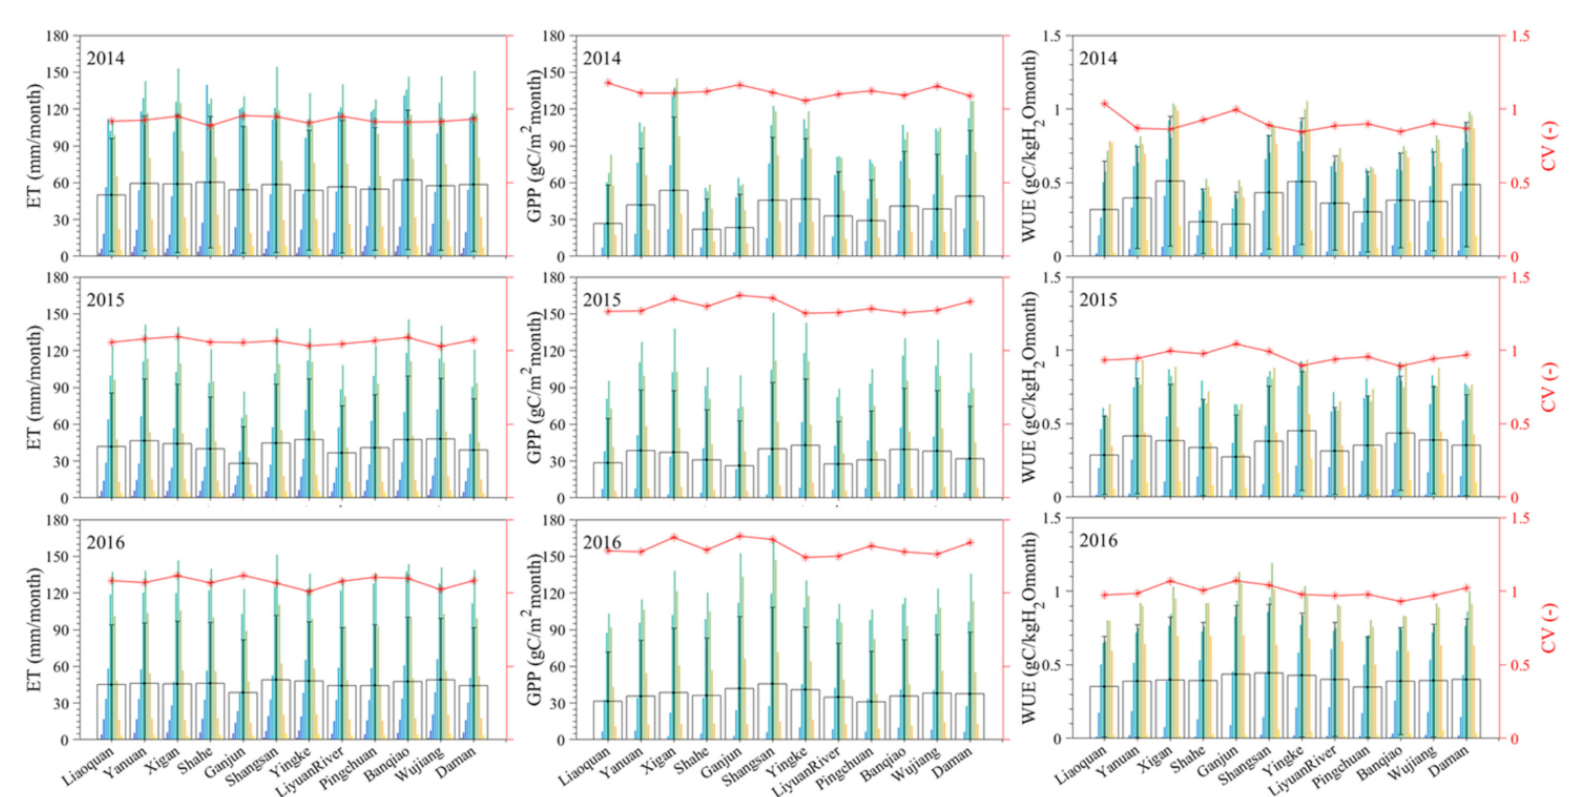
Figure 6. Spatiotemporal patterns of monthly average ET, GPP, and WUE composites of cumulative daily ET, GPP, and WUE for 12 irrigation districts for all months in 2010–2016 over midstream oasis agricultural